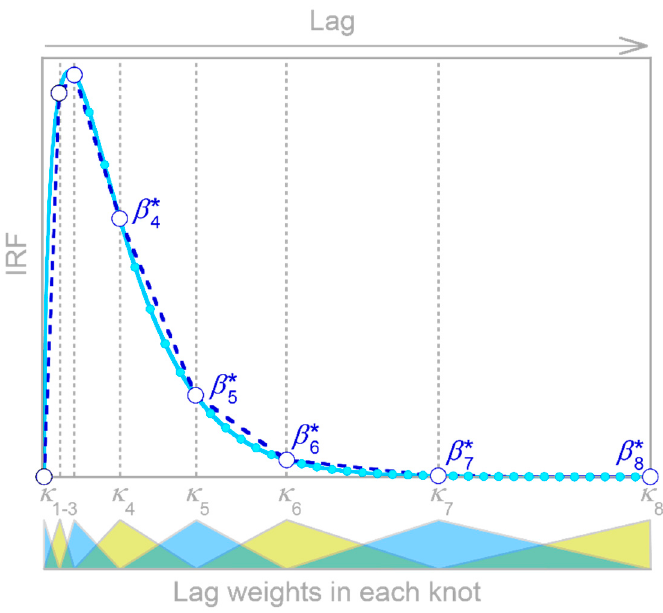
Figure 15. Piecewise linear approximation (dashed dark blue line) to an impulse response function (light blue line), with 40 conventional IRF coefficients (light blue dots) replaced by values at 8 knots (open circles). The overlapping yellow and blue triangles depict the relative influence of each lag on the even and odd numbered knots, respectively (see Equations (51) and (52)).